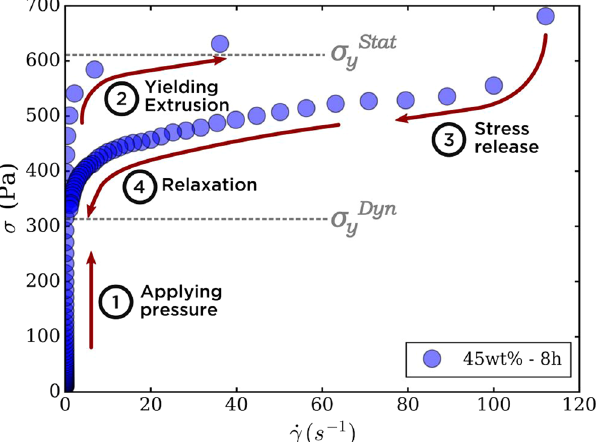
Figure 1. Loop flow curve of a 45 wt% boehmite suspension aged for 8 h. This protocol replicates the shear applied on a printed ink, from the syringe to the printing support. While measuring γ  , an increasing stress controlled ramp was applied (1) until suspension yields at the σ yStat (2). When γ  exceeded 100 s − 1 (3), a decreasing shear rate controlled ramp was applied until γ = −  s 1 1 and stress relaxes at σ yDyn value